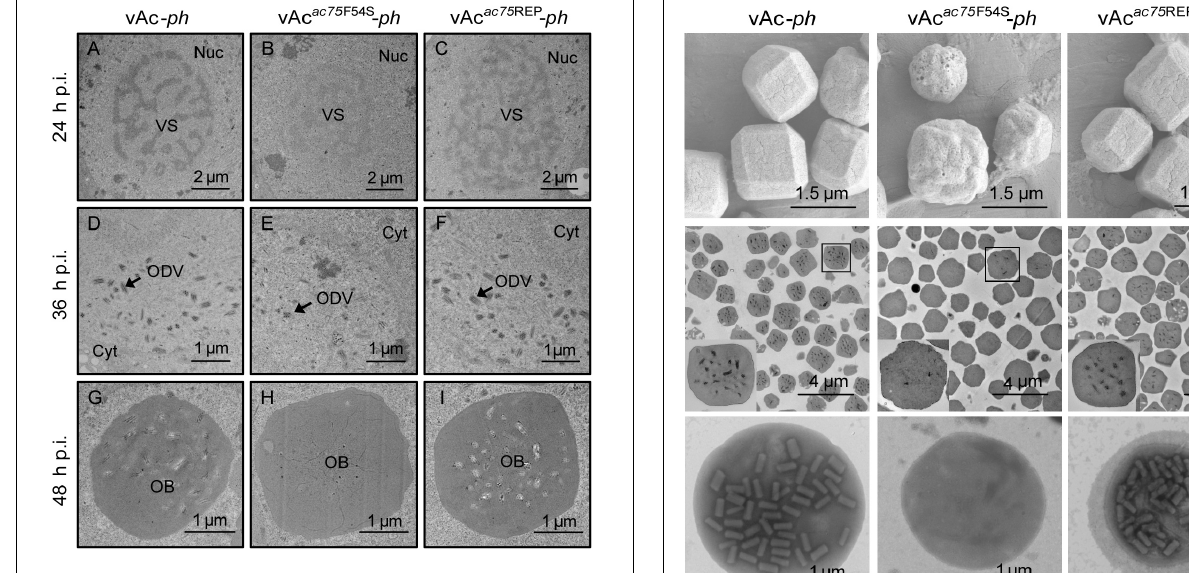
FIGURE 4 | TEM analysis of cells infected with vAc- ph , vAc ac 75 F 54 S - ph , or vAc ac 75REP - ph . Sf9 cells were infected with vAc- ph , vAc ac 75 F 54 S - ph or vAc ac 75REP - ph . The cells were collected at 24, 36, and 48 h p.i., and prepared for TEM. (A–C) The enlarged nucleus (Nuc) and virogenic stroma (VS) in vAc- ph , vAc ac 75 F 54 S - ph or vAc ac 75REP - ph -infected cells at 24 h p.i. (D–F) The normal ODVs in the nucleus ring zone of cells infected with vAc- ph , vAc ac 75 F 54 S - ph or vAc ac 75REP - ph at 36 h p.i. Cyt, cytoplasm. (H) The OB with a few ODVs in vAc ac 75 F 54 S - ph -cells at 48 h p.i. (G,I) Normal OBs in vAc- ph or vAc ac 75REP - ph -infected cells at 48 h p.i.